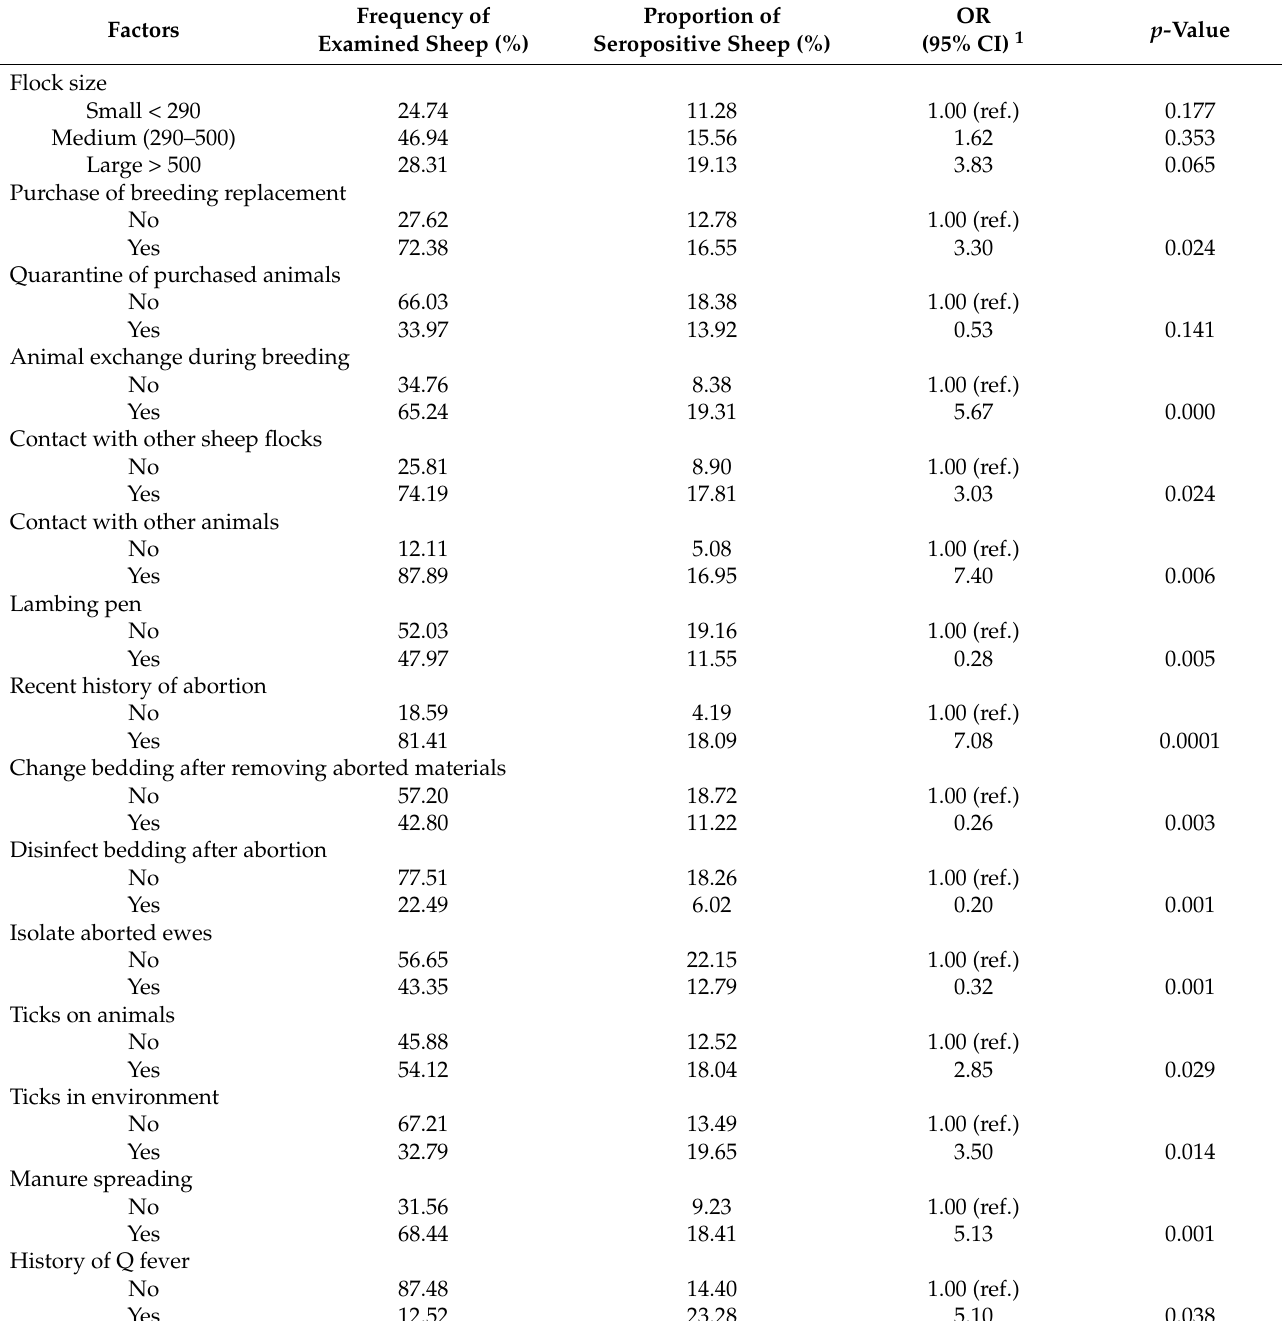
Table 1. Univariable analysis of flock management risk factors association ( p < 0.20) with Q fever seropositivity among sheep sampled from 50 flocks in Eastern Province, Saudi